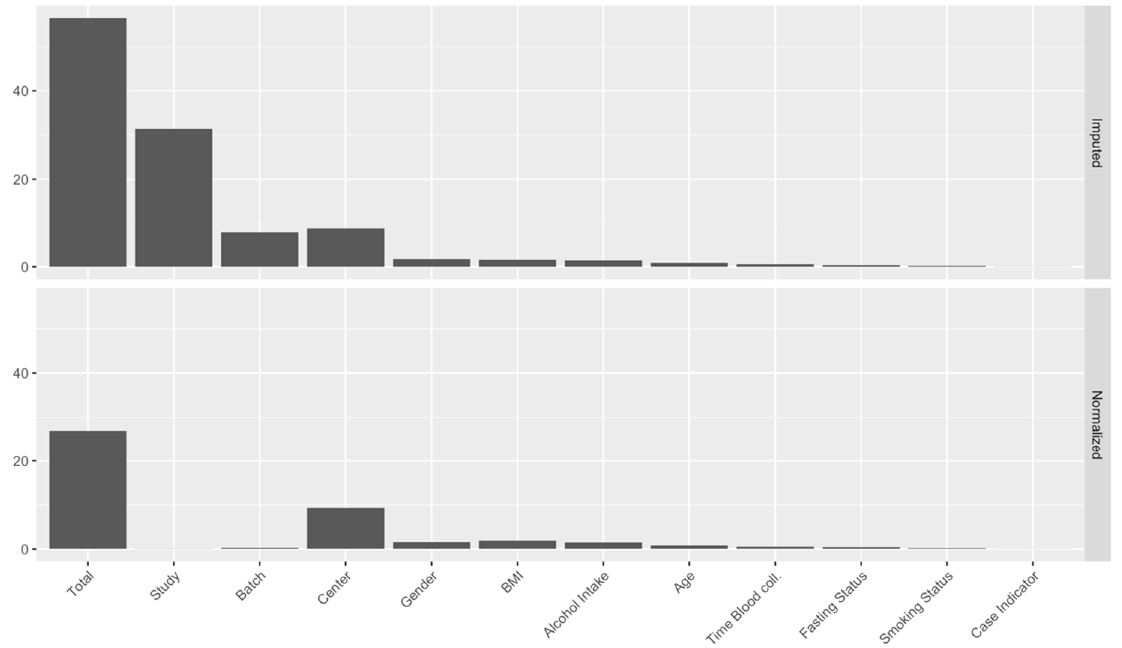
Figure 2. Results from the PC-PR2 analysis of the imputed data (i.e., before the normalization step; ( top )) and the normalized data ( bottom ). In each plot, the y − axis represents the proportion (expressed as a percentage) of the total variation of the metabolomics measurements explained by each variable represented on the x − axis, together with their total.